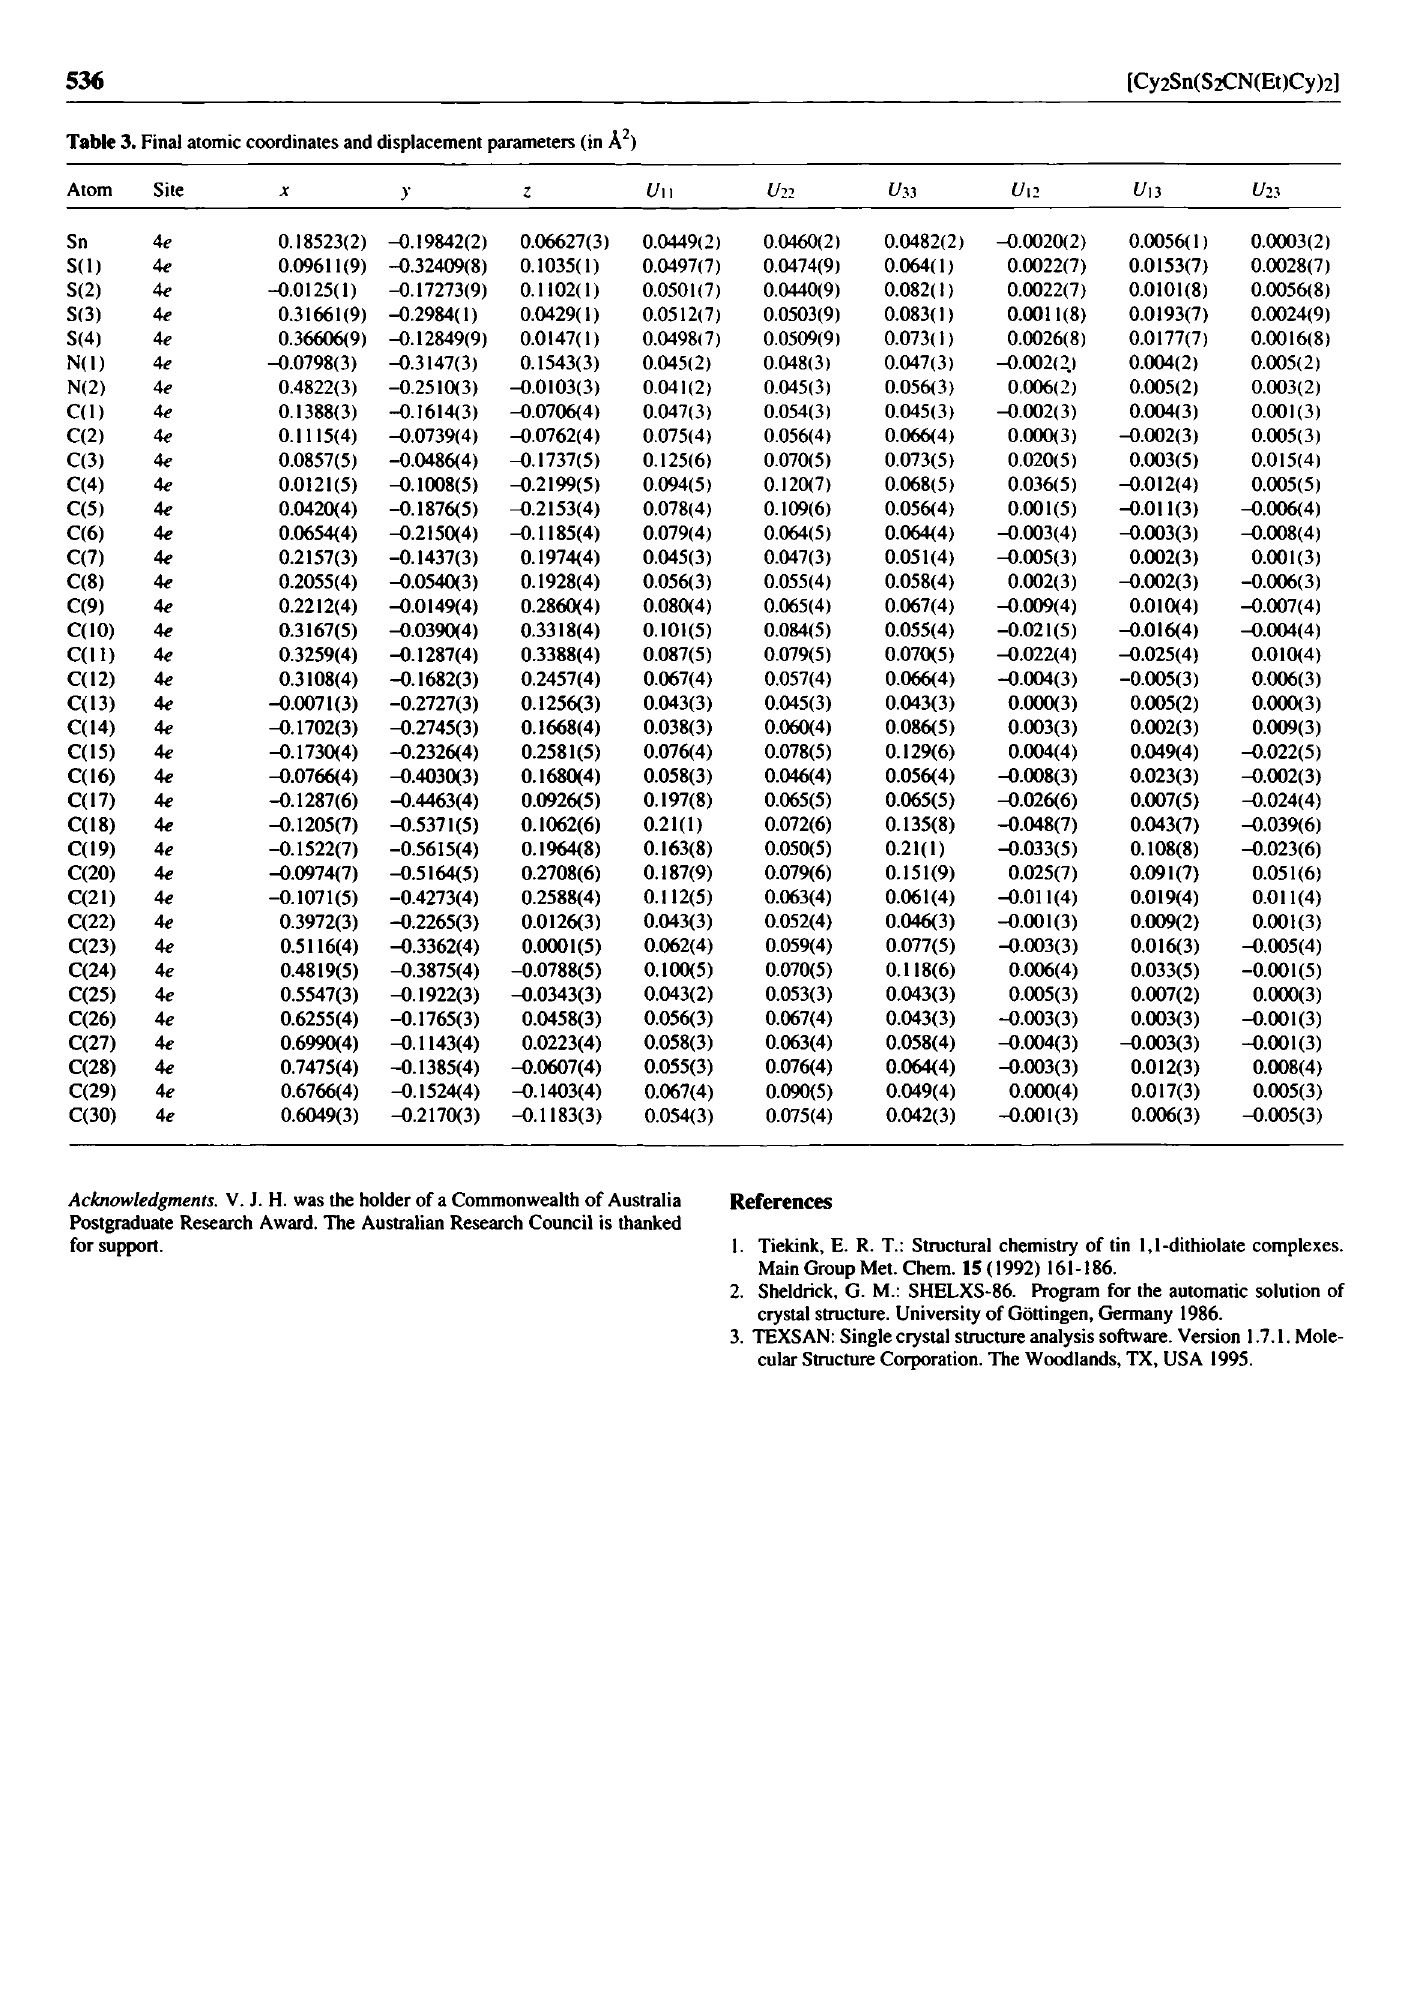
Table 3. Final atomic coordinates and displacement parameters (in